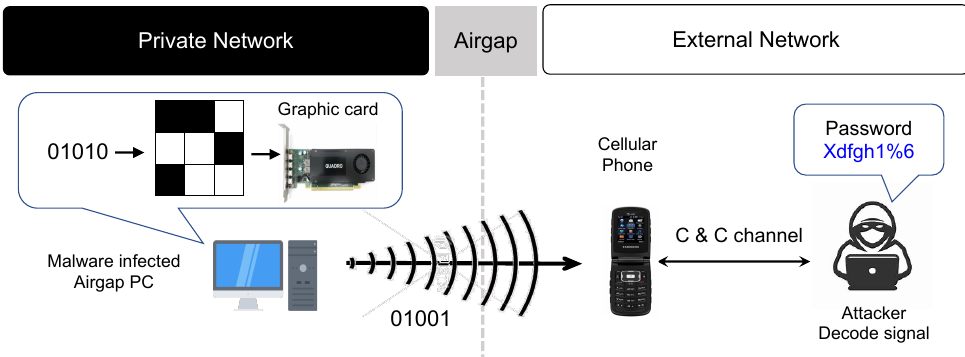
Figure 4. Conceptual diagram of an air-gap attack using graphics card FM